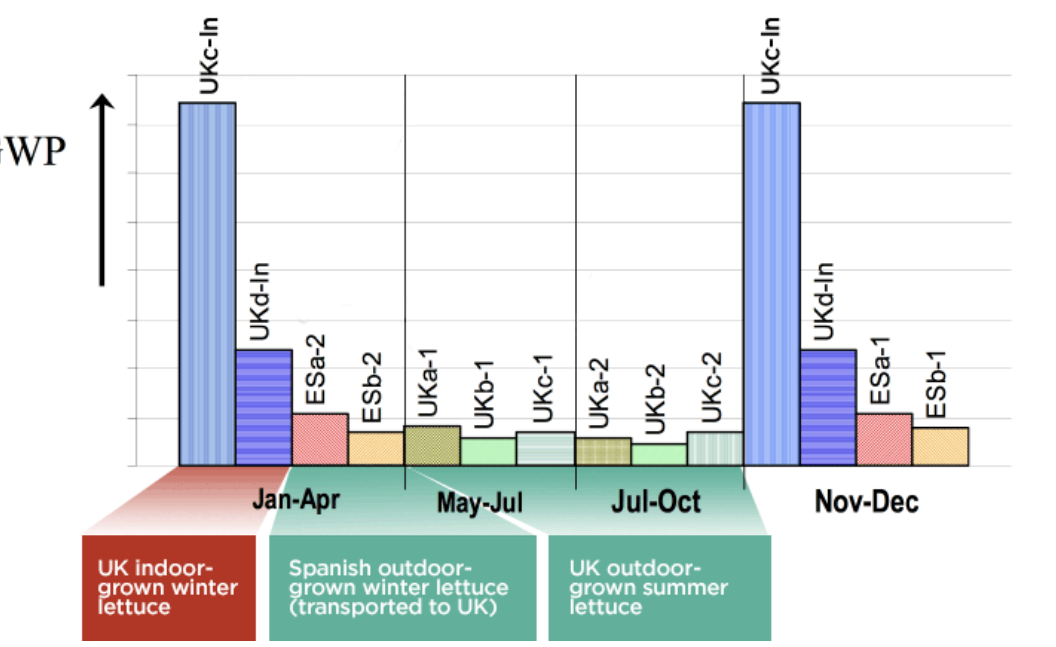
Figure 16: The effect of season and location on greenhouse gas emissions from lettuce